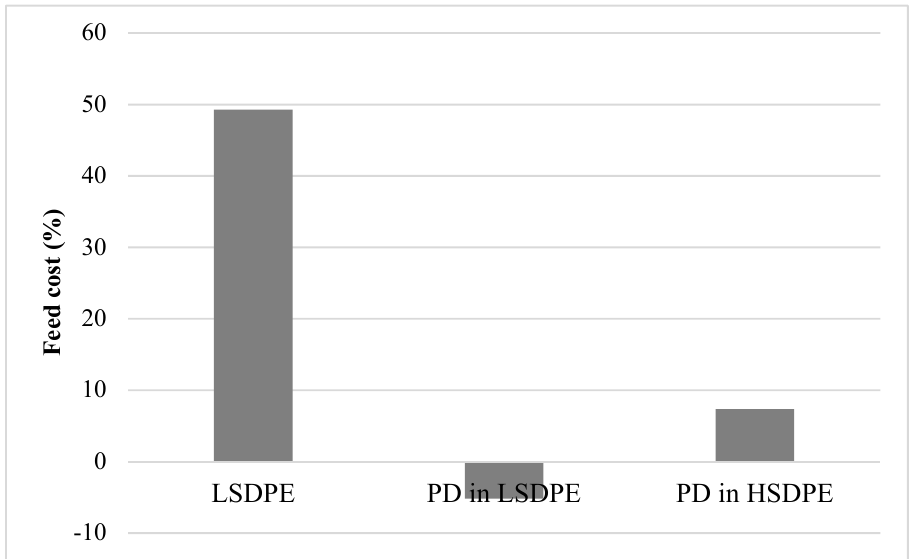
Figure 1. Mean percentage differences in feed cost per animal per year in positive deviants (PD) and typical farms under low-stress (LSDPE) and high-stress (HSDPE) environments.